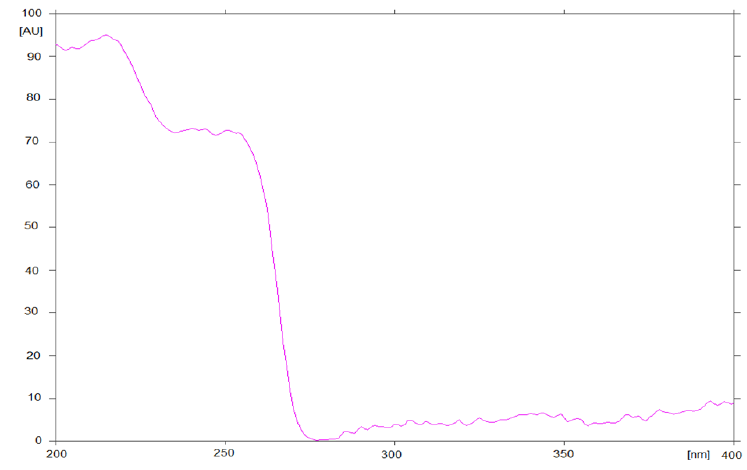
Figure 1. An absorption spectrum of grapiprant, recorded directly from the chromatogram. For quantitative analysis, the areas of the corresponding peaks recorded on the densi- tograms were used (Figure 2).